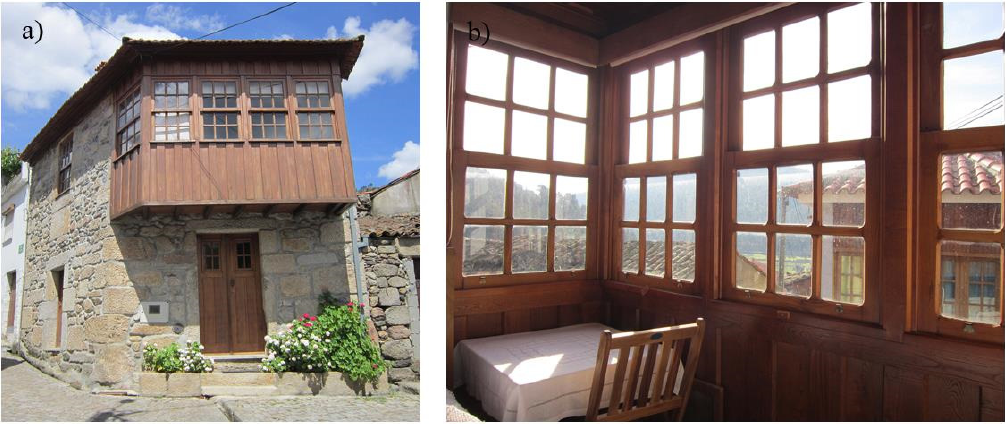
Figure 4. ( a ) Case study 1—External view; ( b ) Inside view of the